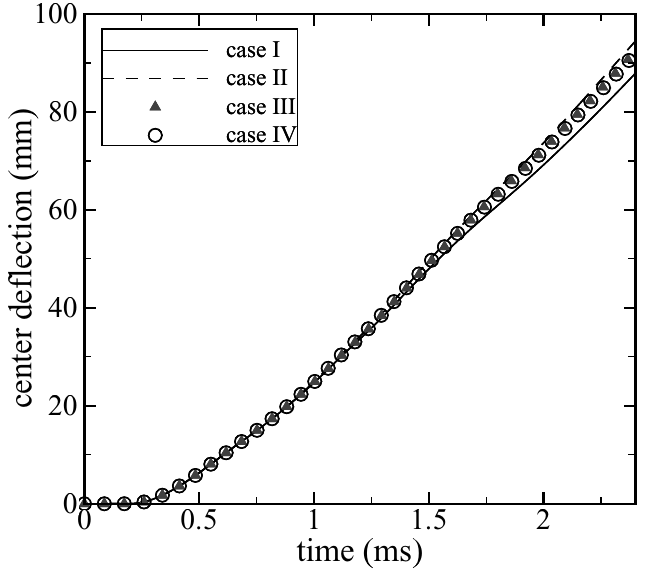
Fig. 20. Influence of the bonding sequence on the mid-span